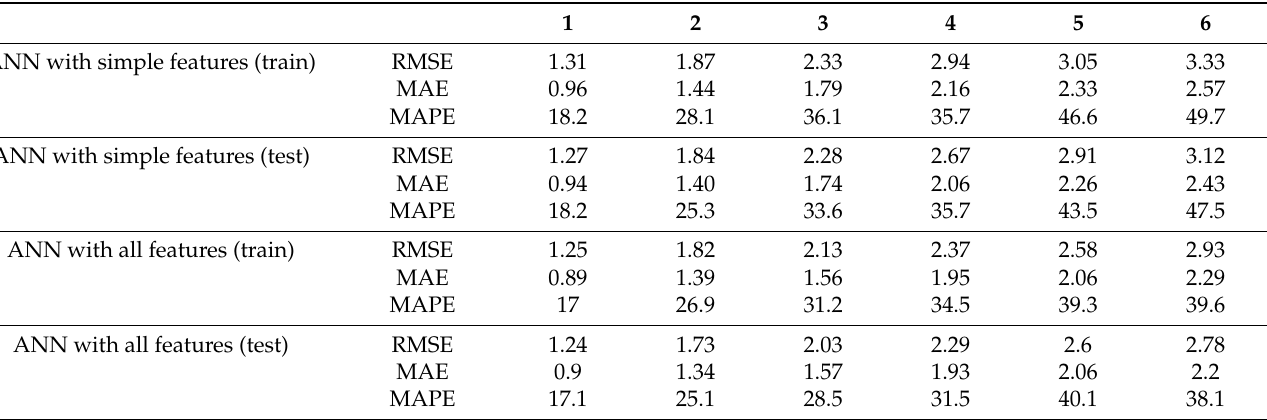
Table 4. The error criteria comparison of the ANN model using simple and all features (new features included).